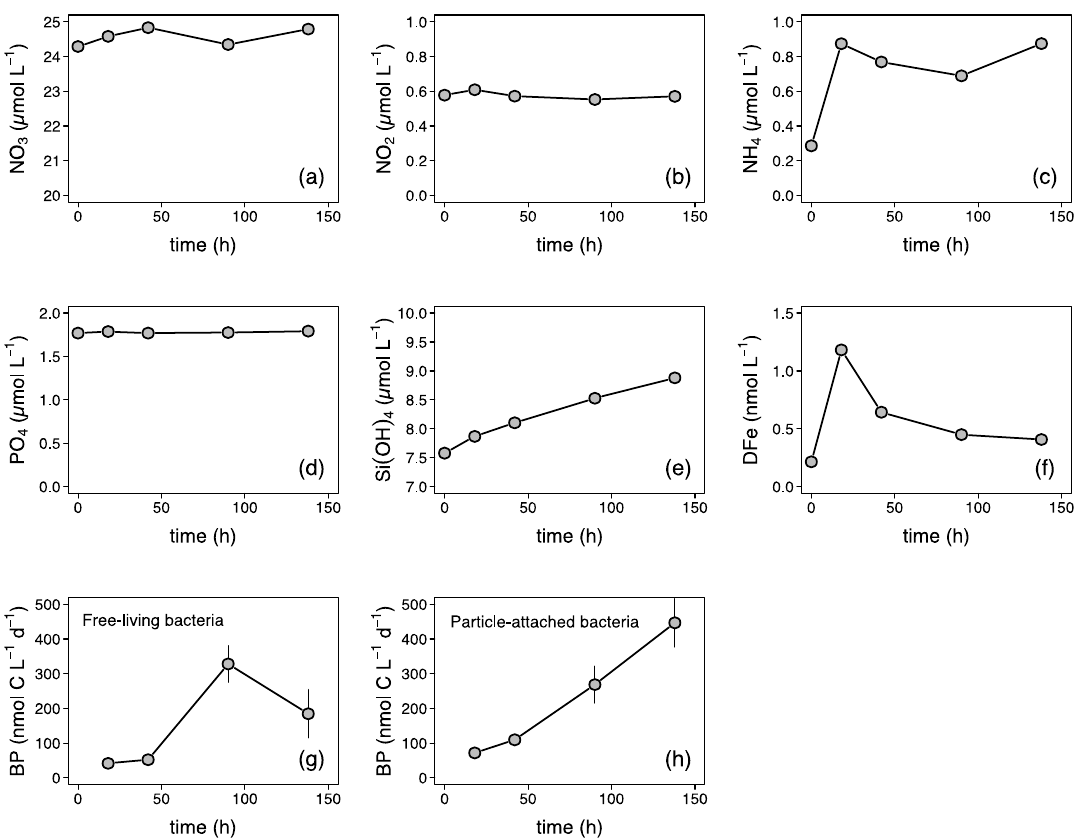
Figure 2. Time evolution of dissolved ( a ) nitrate (NO 3 ), ( b ) nitrite (NO 2 ), ( c ) ammonium (NH 4 ), ( d ) phosphate (PO 4 ), ( e ) silicate (Si(OH) 4 ), and ( f ) dissolved iron (DFe) concentrations, and bacterial production (BP) by ( g ) free-living and ( h ) particle-attached heterotrophic bacteria during the regeneration of subsurface particles (Section 2.2). Particle-attached BP values were obtained by subtracting the free-living (<1-µm) from the total (unfiltered) BP rates.